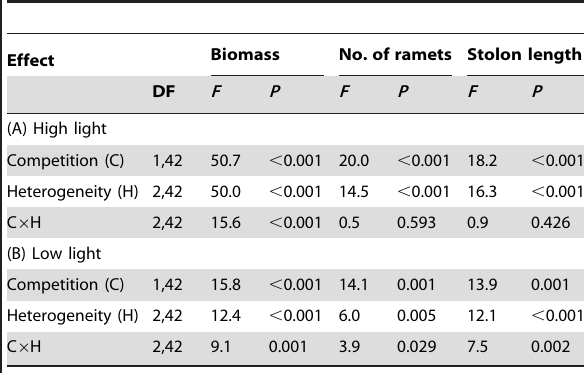
Table 2. ANOVAs for effects of competition and light heterogeneity on the growth measures of Duchesnea indica in the high (A) and low light patches